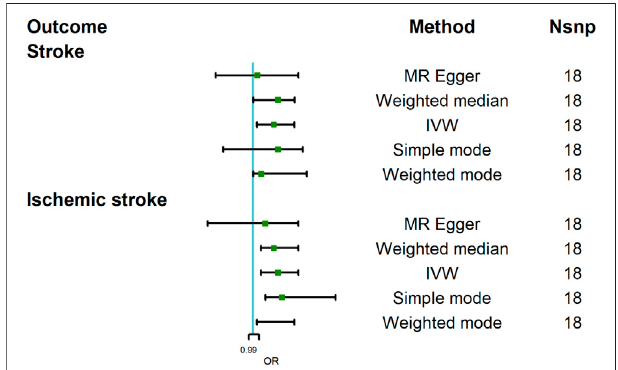
FIGURE 3 | Mendelian randomization analysis results about the causal effects of COVID-19 severity (hospitalization due to COVID-19) on stroke and ischemic stroke. CI, credibility